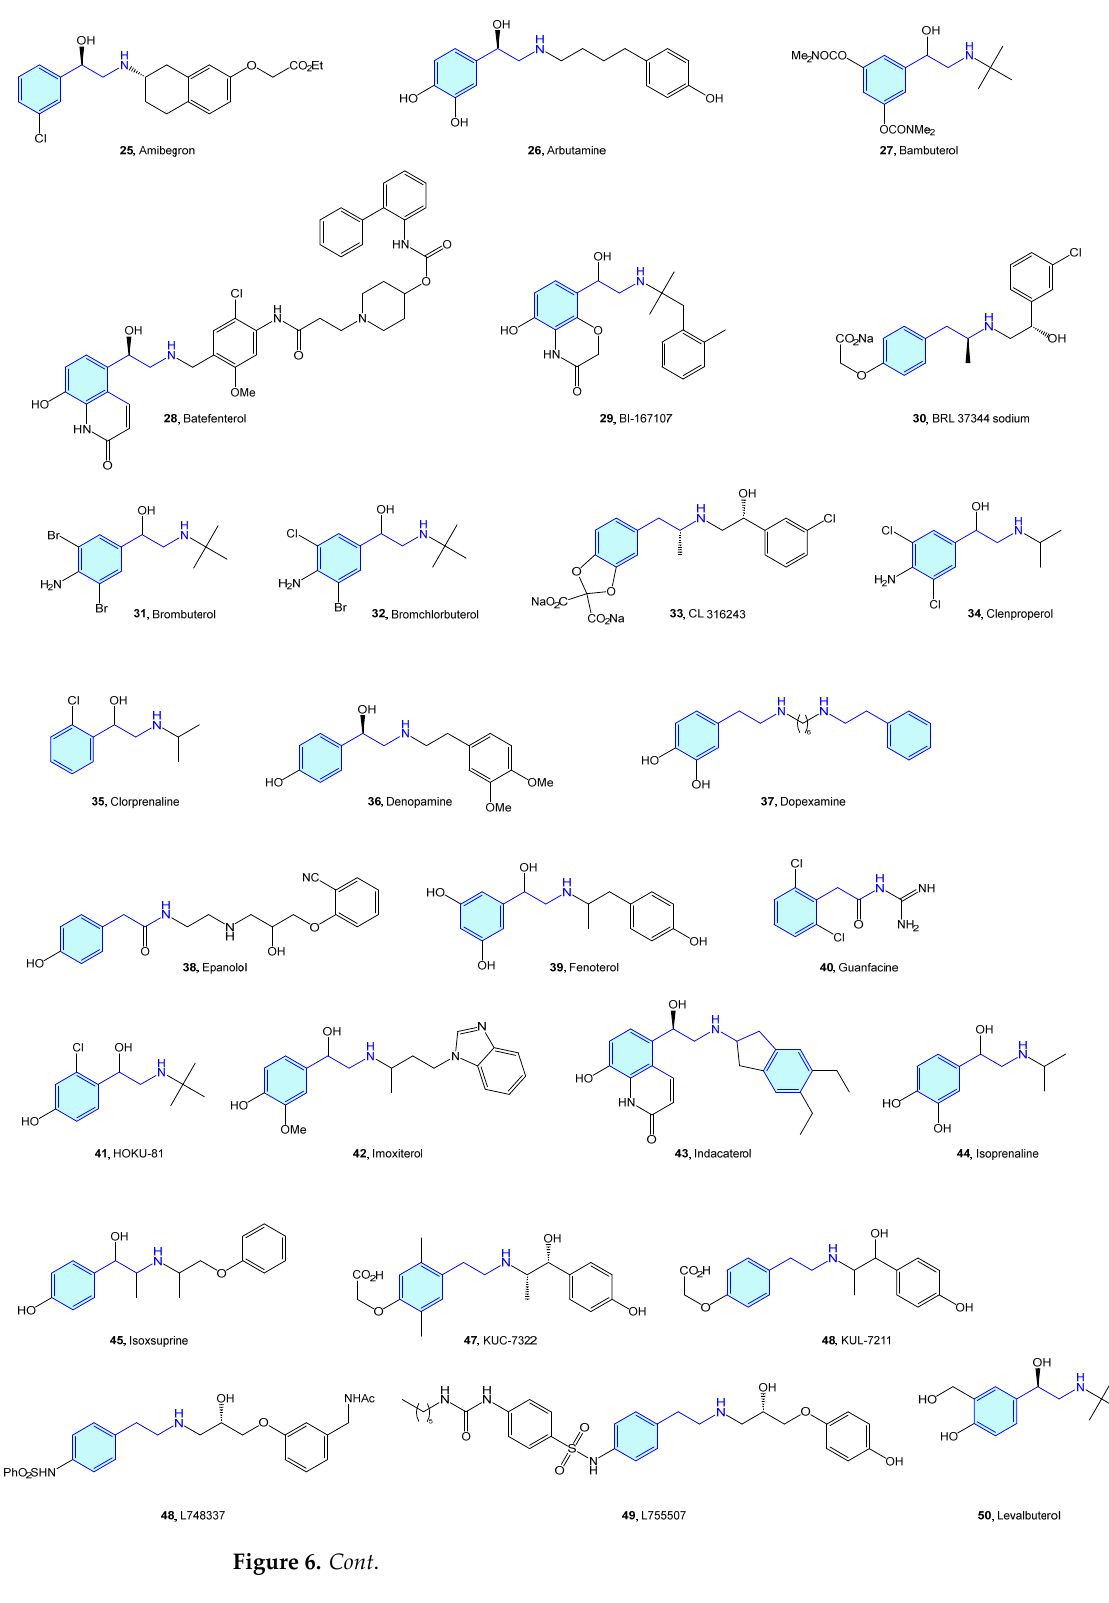
Figure 6. 2-Phenylethyl-based β -adrenergic medicinal chemistry leads. Figure 6. Cont